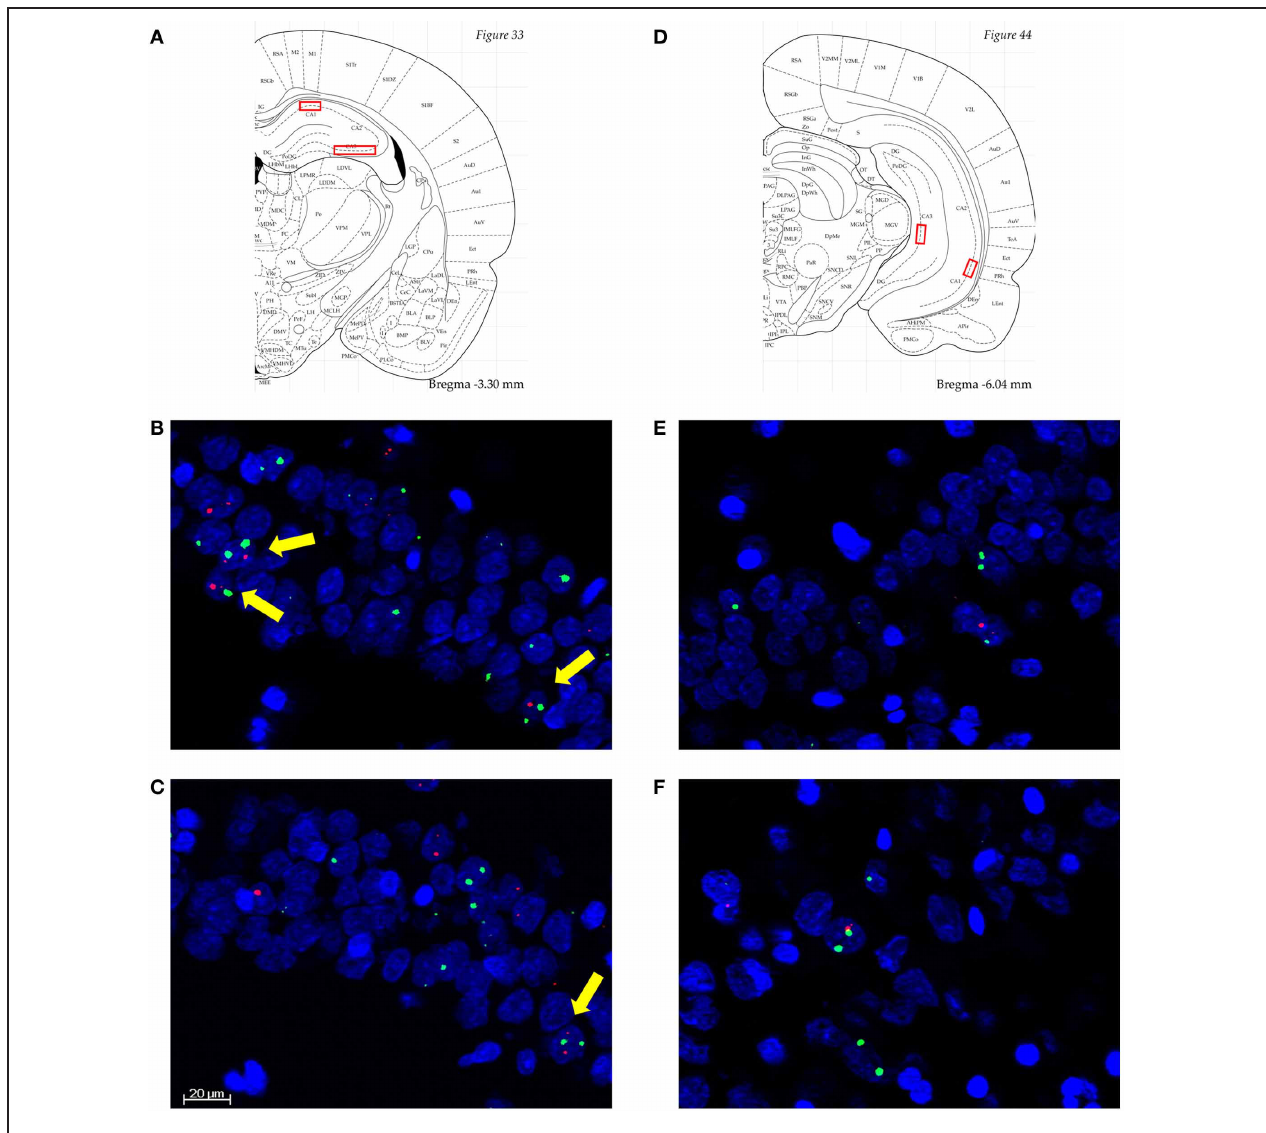
FIGURE 2 | (A) and (D) Diagrammatic representation of the approximate anatomical locations from which the analyzed images were collected (Paxinos and Watson, 4th Edn, Academic Press, San Diego, 1998). Septal/dorsal CA1 (dCA1), temporal/ventral CA1 (vCA1), and vCA3 were single stacks, while dCA3 were mosaics through dCA3b. (B) – (F) Representative images from dCA1 of an A-A rat (B) ; dCA1 of an